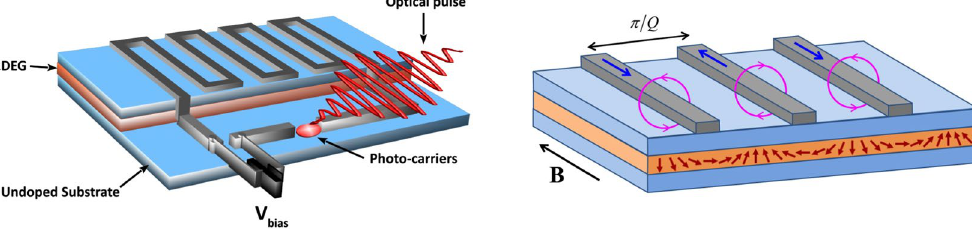
Figure 4. Proposed experimental design for the direct excitation of the spin-helix Larmor mode. Left: photo- conductive antenna on top of the sample, converting an infrared optical pulse into a short current pulse. Right: close-up view of the metal stripes on top of the spin-polarized 2DEG. The currents (blue arrows) are in alternating directions in neighboring stripes; the induced magnetic fields (pink circles) trigger a standing spin wave in the